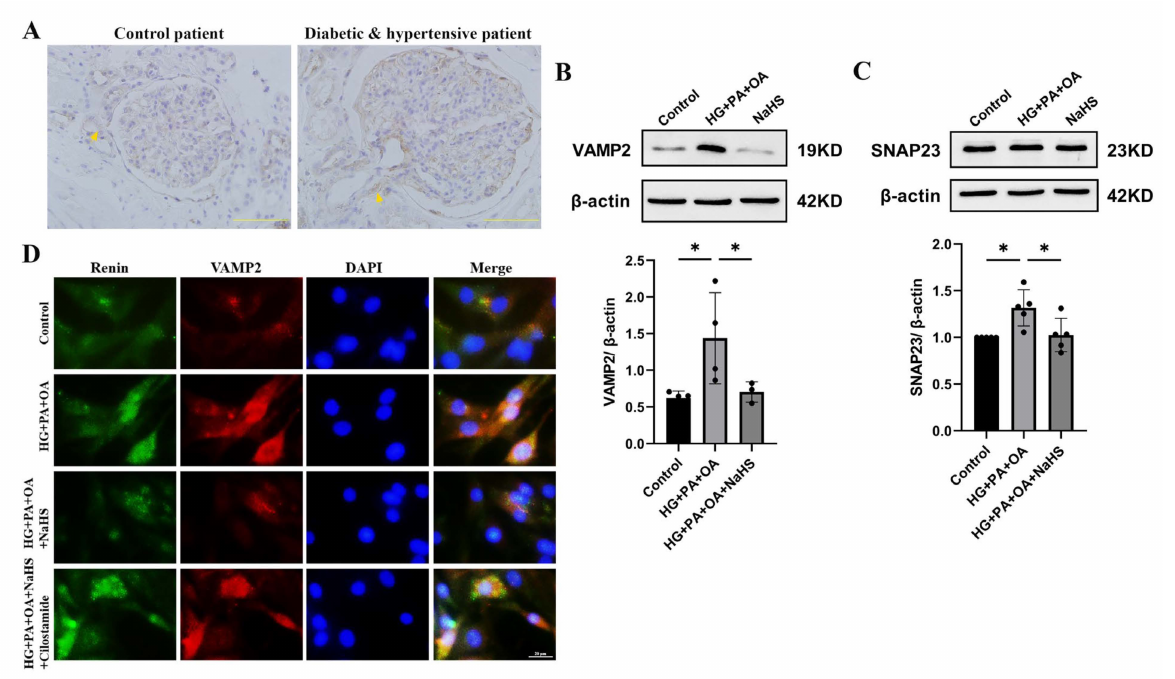
Figure 5. Exogenous H 2 S attenuated renin release via SNARE proteins. ( A ) Immunohischemistry of the expression of VAMP2 in kidney tissues of patients. Scale bar = 50 µ m. ( B , C ) VAMP2 and SNAP23 expression levels in JG cells were measured by Western blotting ( n = 5). ( D ) The colocalization of renin with VAMP2 in JG cells was detected by immunofluorescence staining. Scale bar = 20 µ m. * p < 0.05. VAMP2, vesicle-associated membrane protein 2. SNAP23, synaptosome-associated protein